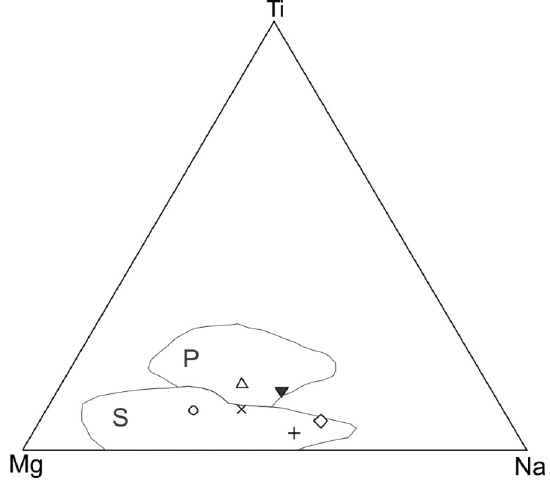
Table 1 - Stable oxygen isotope results for samples of the Castelo de Sonhos gold deposit